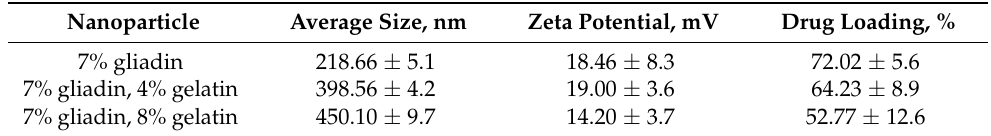
Table 4. Properties of gliadin and gliadin-gelatin nanoparticles produced using the electrospray technique. Reprinted with permission from ref. [97]. Copyright 2012 American Chemical